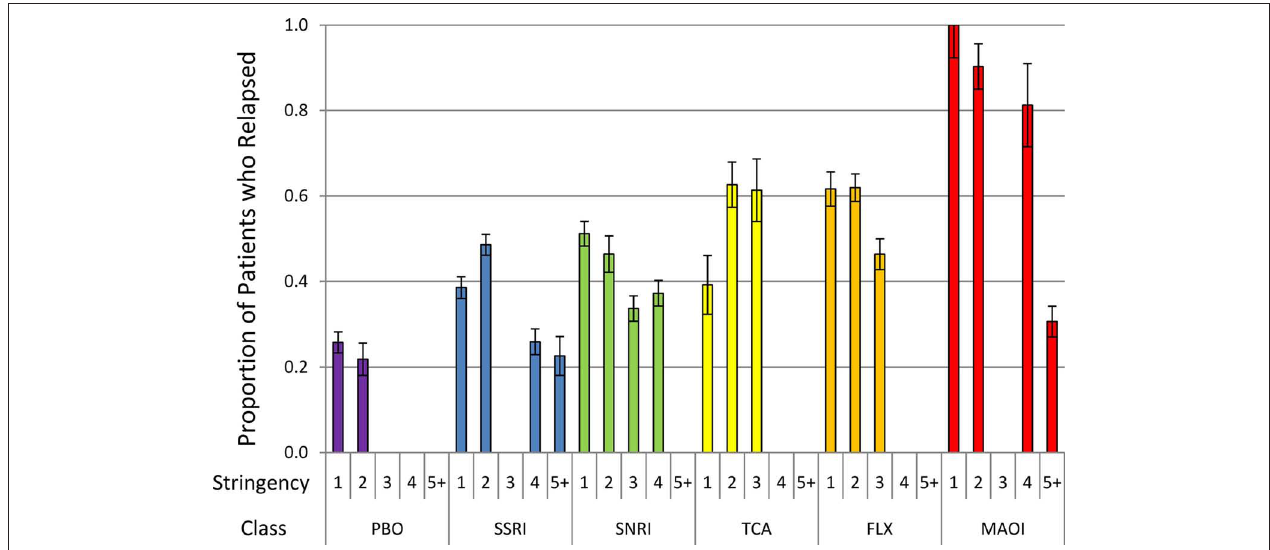
FiguRE 3 | unadjusted proportions (with SE bars) of patients with a relapse after discontinuation (to placebo) ( y -axis) as a function of the stringency of the definition of relapse ( x -axis) for each ADM